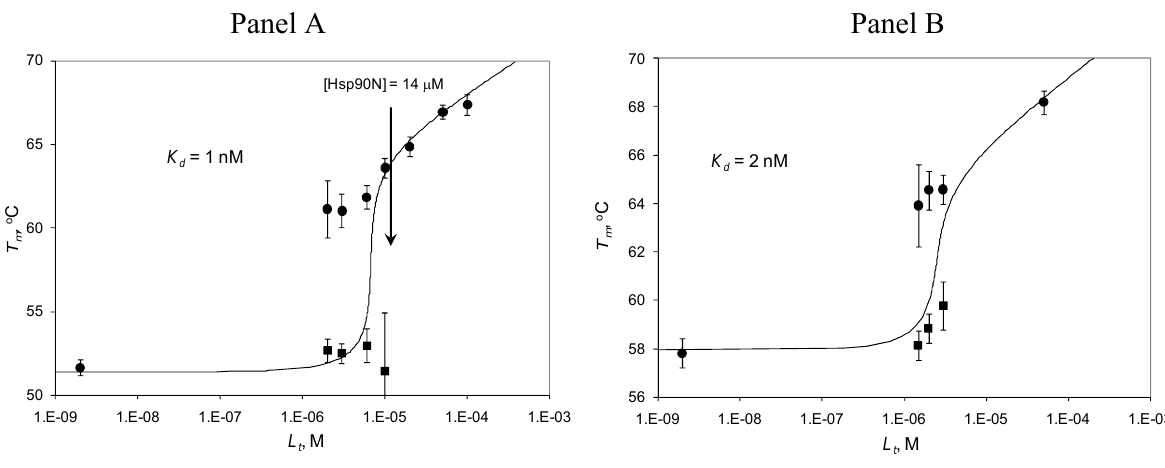
Figure 3. The protein melting temperature dependence on inhibitor concentration. Panel A. Hsp90 α N with radicicol (from the melting curves in Figure 2A). Panel B. hCAII with ethoxzolamide (from the melting curves in Figure 2B). The data points show the melting temperatures of the ligand-bound ( (cid:122) ) and ligand-free ( (cid:132) ) forms of the protein. The leftmost data point is the control where no inhibitor was added. Lines are the fit to the data according to Equation (12). Panel A Panel